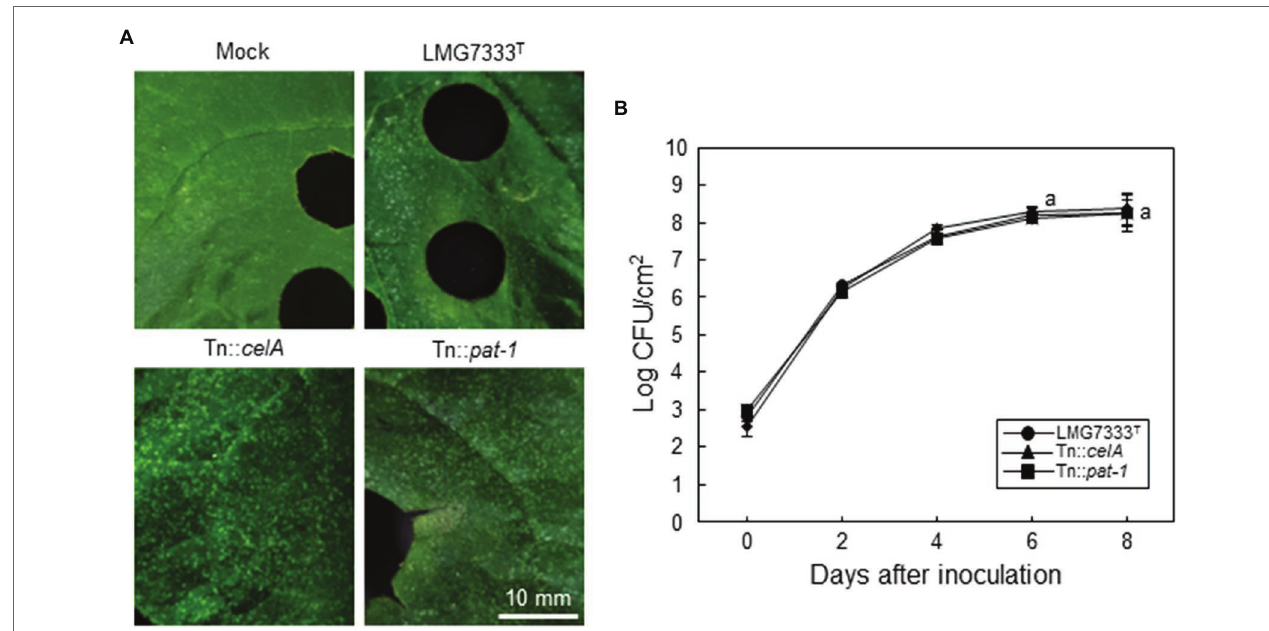
FIGURE 3 | No contribution of two major virulence genes of C . michiganensis to the development of blister-like symptoms on N . benthamiana leaves. (A) Blister- like symptoms on N . benthamiana leaves by infiltration of 5×10 4 CFU/ml C . michiganensis LMG7333 T and its Tn:: celA or Tn:: pat-1 mutant strains. The leaves were photographed at 8 days after inoculation (dai). (B) The bacterial growth of C . michiganensis LMG7333 T , Tn:: celA, and Tn:: pat-1 strains in N . benthamiana leaves at the indicated time points. An average and standard deviation ( n = 3) of each bacterial titer are shown in the figure. The letters at 6 and 8 dai in the graphs indicate a statistically significant difference analyzed via Duncan’s multiple range test ( p < 0.05). Similar results were obtained from three independent assays. Scale bar = 10